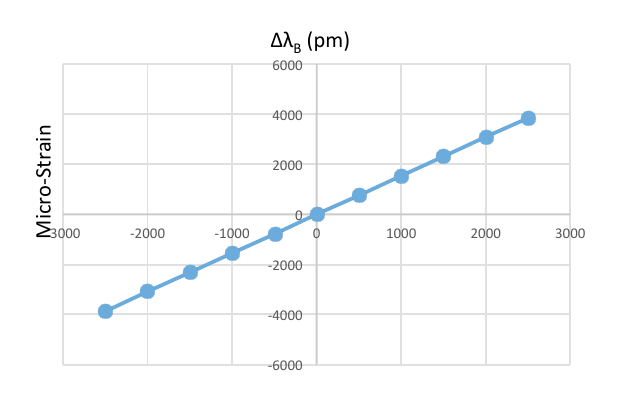
Figure 14: Linearity in proposed FBG strain sensor (Left side: Compressive, Right side: